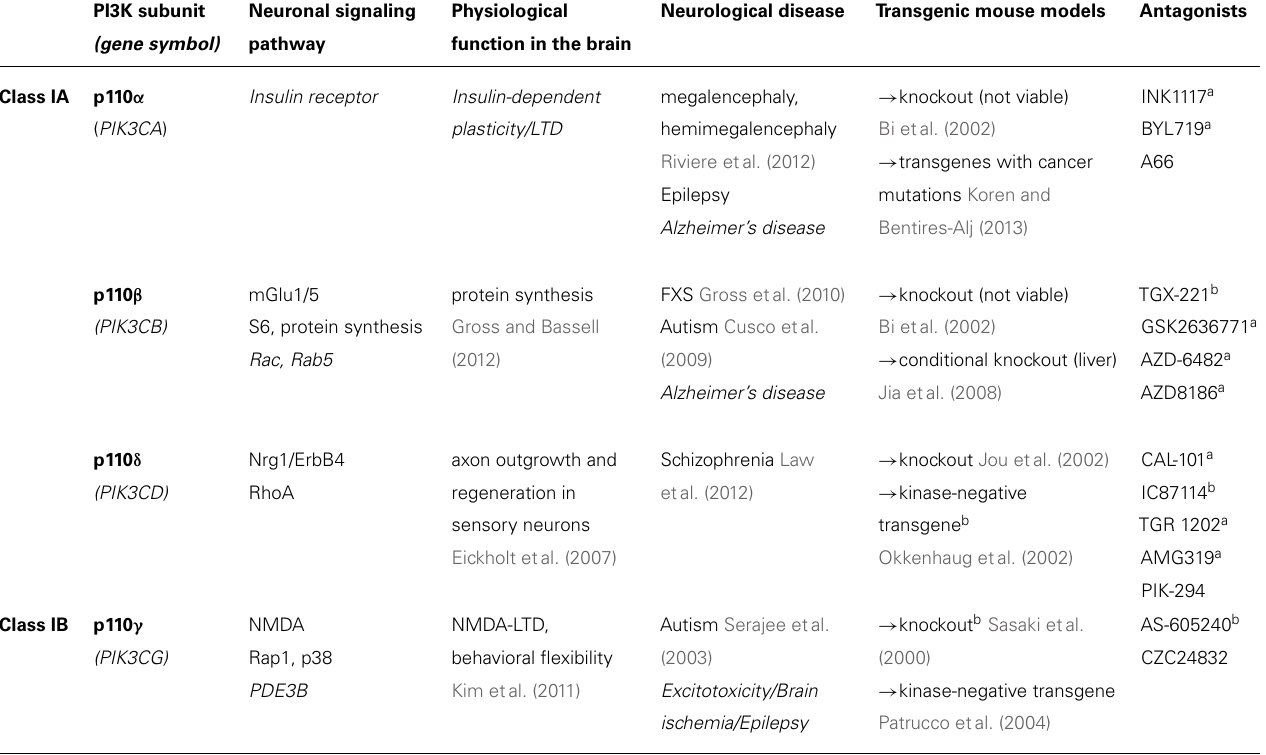
Table 1 |This table summarizes the current knowledge about neuron-specific signaling and function of class I PI3K catalytic subunits and lists available tools for their future study (transgenic mouse models and